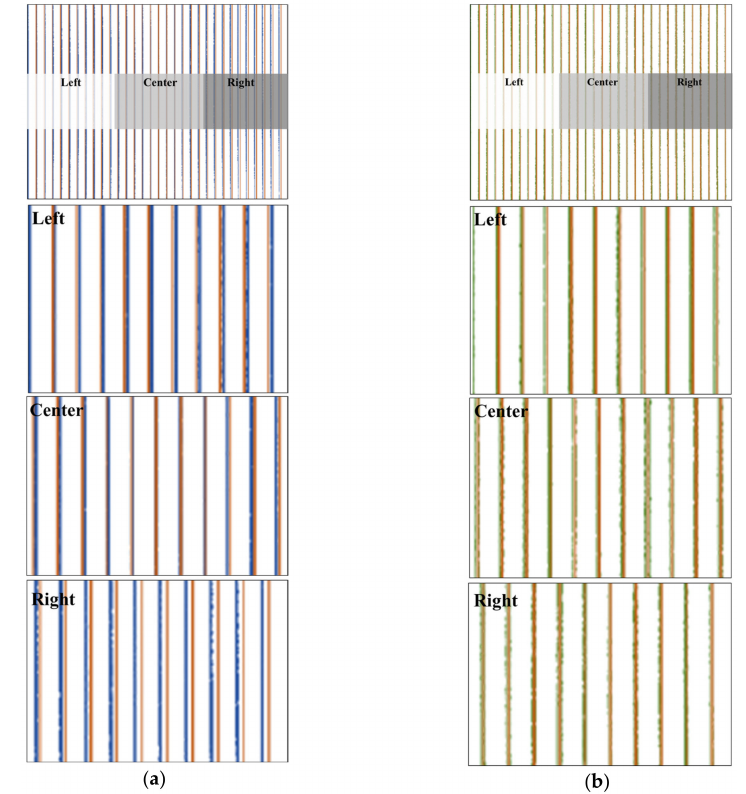
Figure 2. Comparison of the degree of distortion on the left, right, and central regions and before and after distortion correction. When compared with the ideal lines (in orange), the distorted lines (in blue) in ( a ) are corrected to the corrected lines (in green) in ( b ) to match the ideal lines. ( a ) overlap images of the ideal lines and distorted lines of the left, central, and right regions, ( b ) overlap images of the ideal lines and corrected lines of the left, central, and right